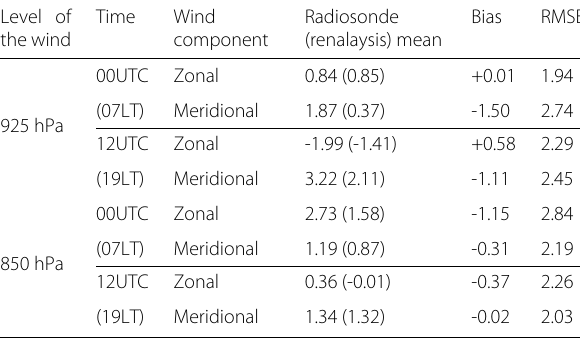
Table 3 Comparison of zonal and meridional wind components in JRA-55 dataset with those in radiosonde dataset at Hanoi Level of the wind